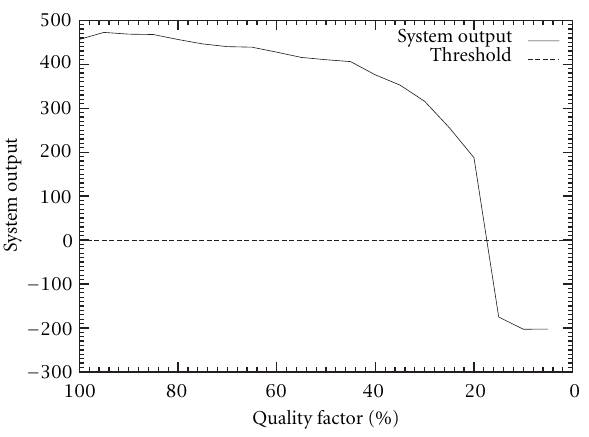
Figure 11: Robustness against JPEG coding with decreasing quality factor. The image in Figure 10a was rotated by 67 degrees, scaled with a scale factor equal to 1 . 5 , and JPEG-coded with a decreasing quality factor ranging from 100 % through